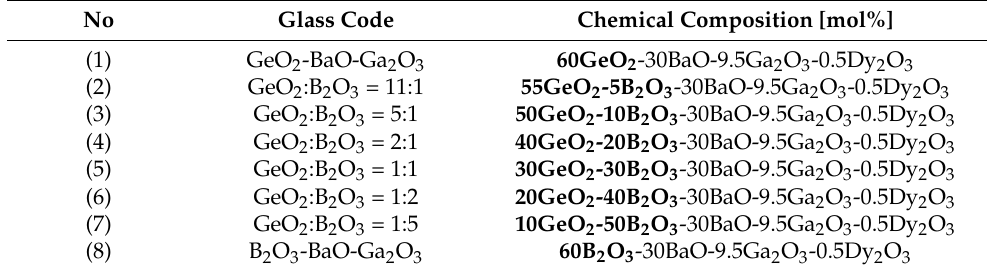
Table 1. Glass codes and chemical compositions for glass samples doped with Dy 3+ ions. No Glass Code Chemical Composition